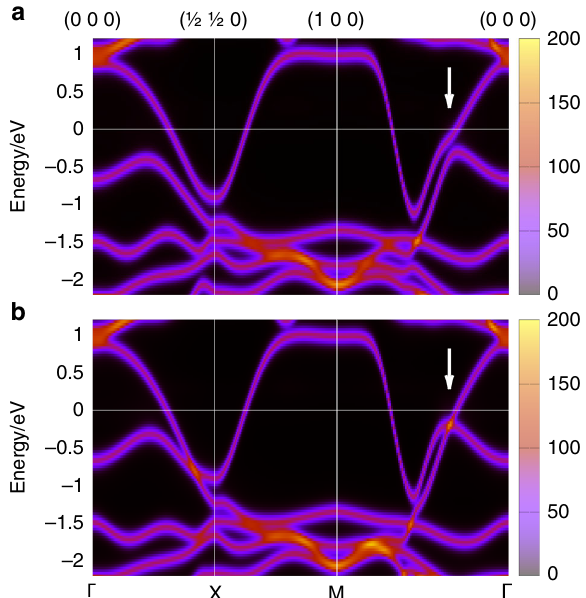
Fig. 7 Bloch spectral function calculated within the CPA for 0.5%-Au-rich Mn 2 Au for two orientations of the Néel vector: a || [100] and b || [010]. The white arrows mark the major changes of the spectral function induced by the Néel vector